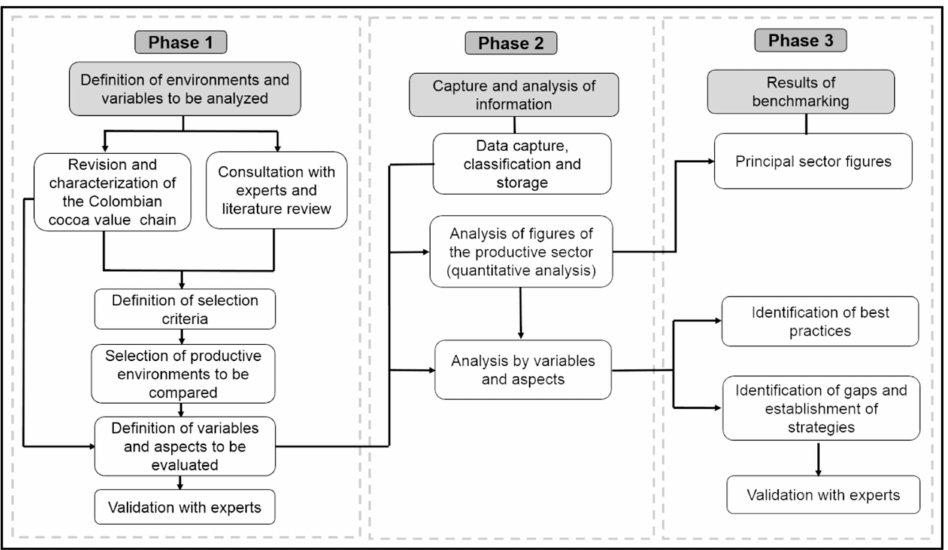
Figure 5. Benchmarking methodology. Source: Reference